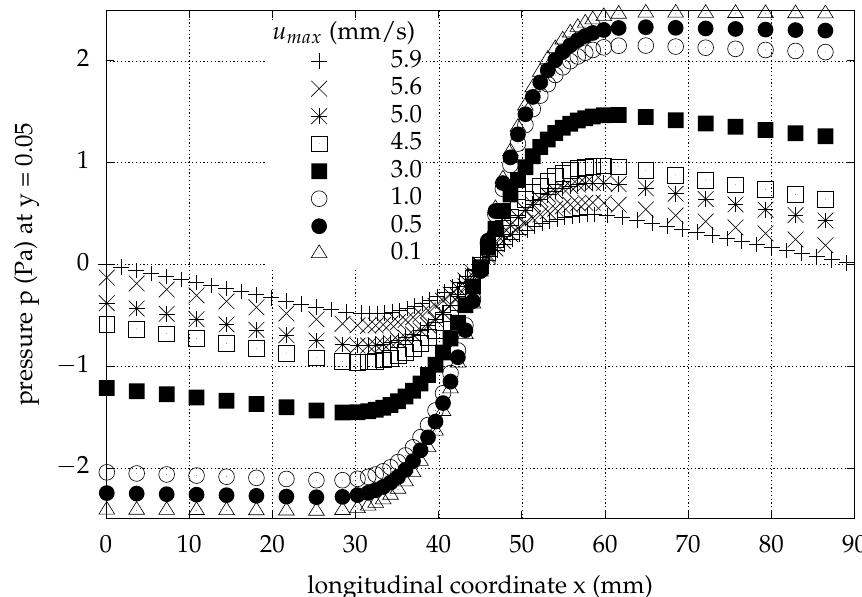
Figure 20. Longitudinal pressure distribution for the case of one pair roller pump, 90 mm long, c = 5 mm/s, RO = 0.6, n = 1 and parabolic flow inlet profile with various values for maximum velocity.